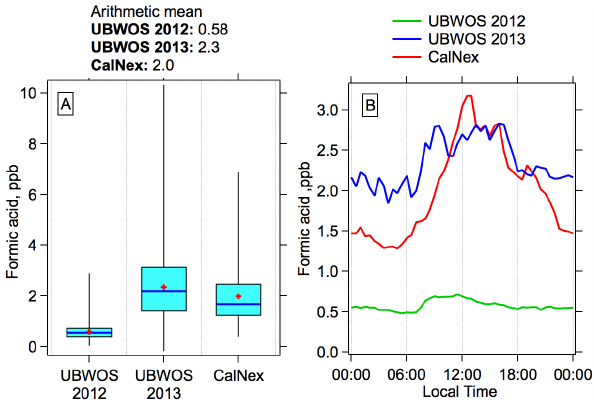
Figure 1. (a) Box-whisker plots of formic acid concentrations in UBWOS 2012, UBWOS 2013 and CalNex. The boxes denote the central 50% of the data (25–75%), and the bars within the box in- dicate the median value. The ends of the whiskers show the maxi- mum and minimum of the data. The cross markers show arithmetic mean concentrations of formic acid. (b) Diurnal variations (arith- metic mean) of formic acid in UBWOS 2012, UBWOS 2013 and